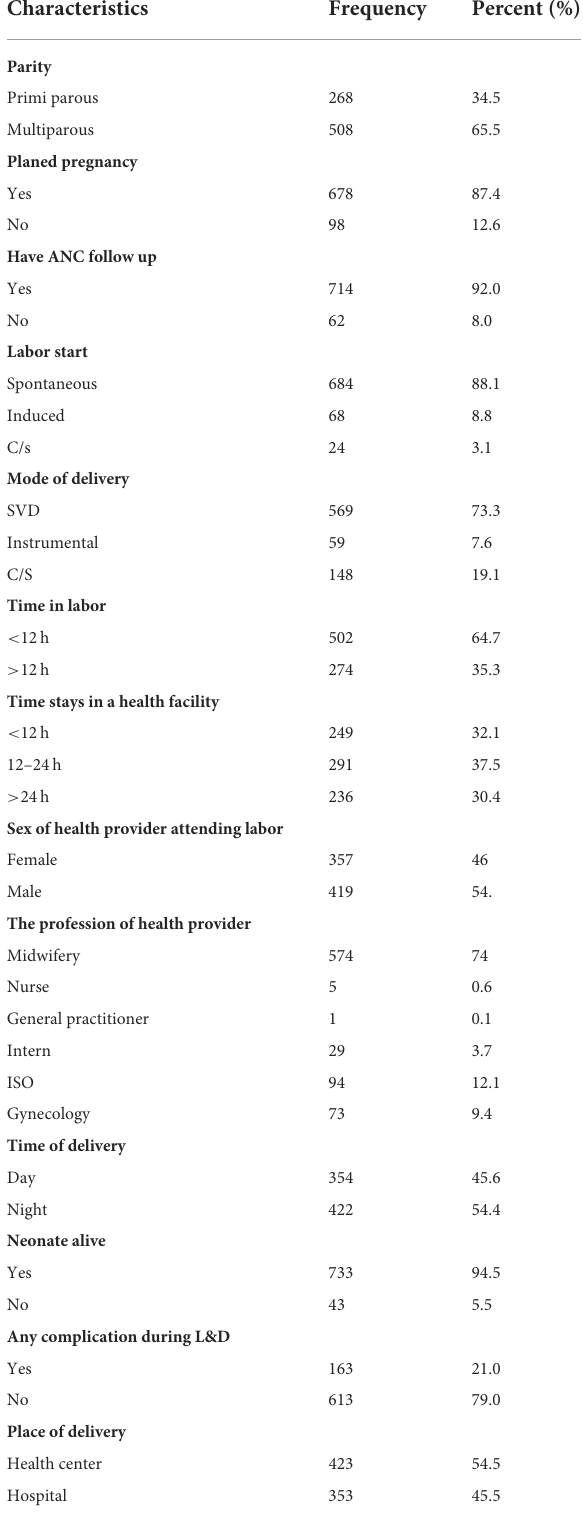
TABLE 2 The Obstetric/health care service-related characteristics among women who gave birth in north Showa zone public health institutions, North Showa zone, Ethiopia, 2020 ( N =